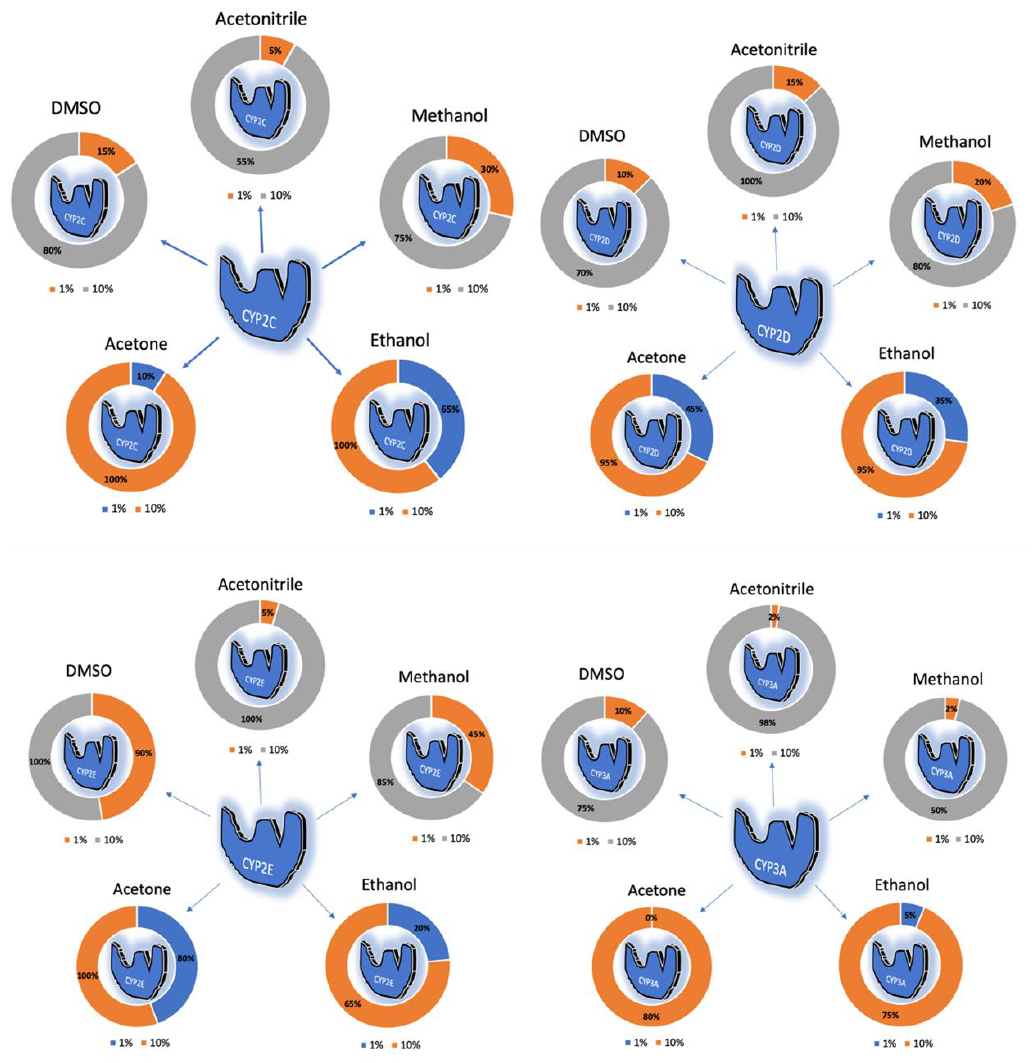
Figure 2. Illustrates the inhibition of CYP2C, CYP2D, CYP2E, CYP3A and CYP1A by acetonitrile, methanol, ethanol, acetone and DMSO at 1% and 10% methanol, ethanol, acetone and DMSO at 1% and 10% concentrations.